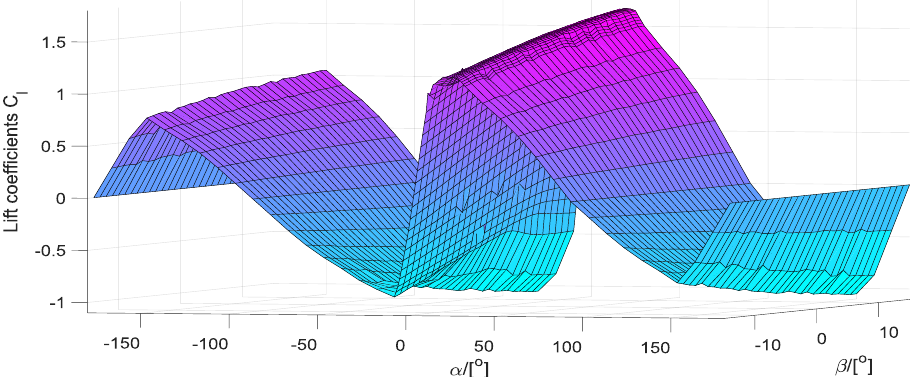
Figure 4. The lift coefficients as function of both angles of attack ( ± 180 ◦ ). and TEFs deflection angles ( ± 15 ◦